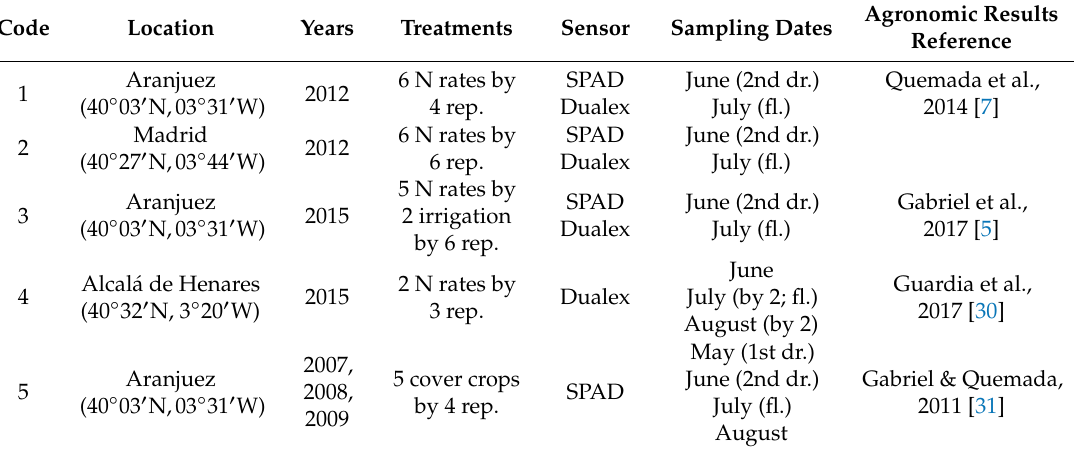
Table 1. Summary of the five experiments used for the three